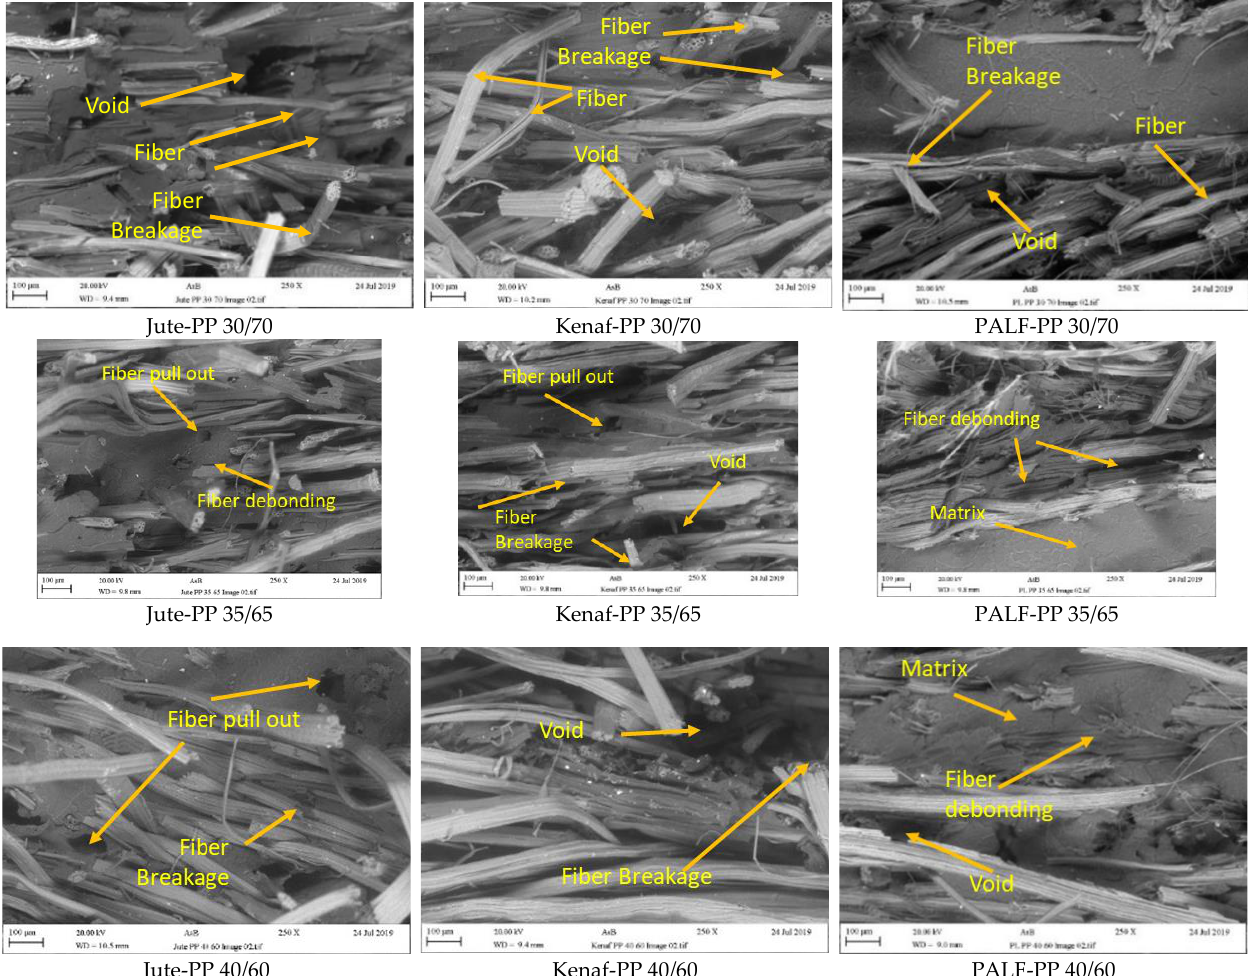
Figure 12. SEM images of fractured composites reinforced with different wt.% of jute, kenaf and PLAF fibers.